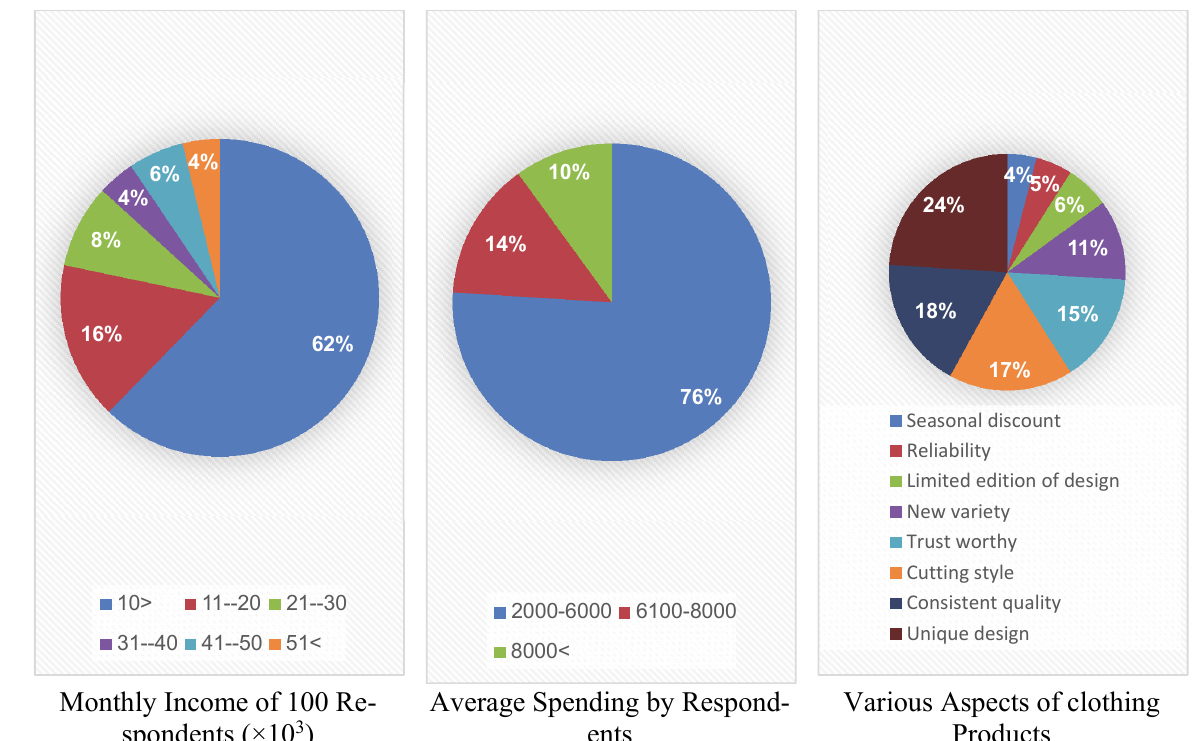
Fig. 3. Personal characteristics of the